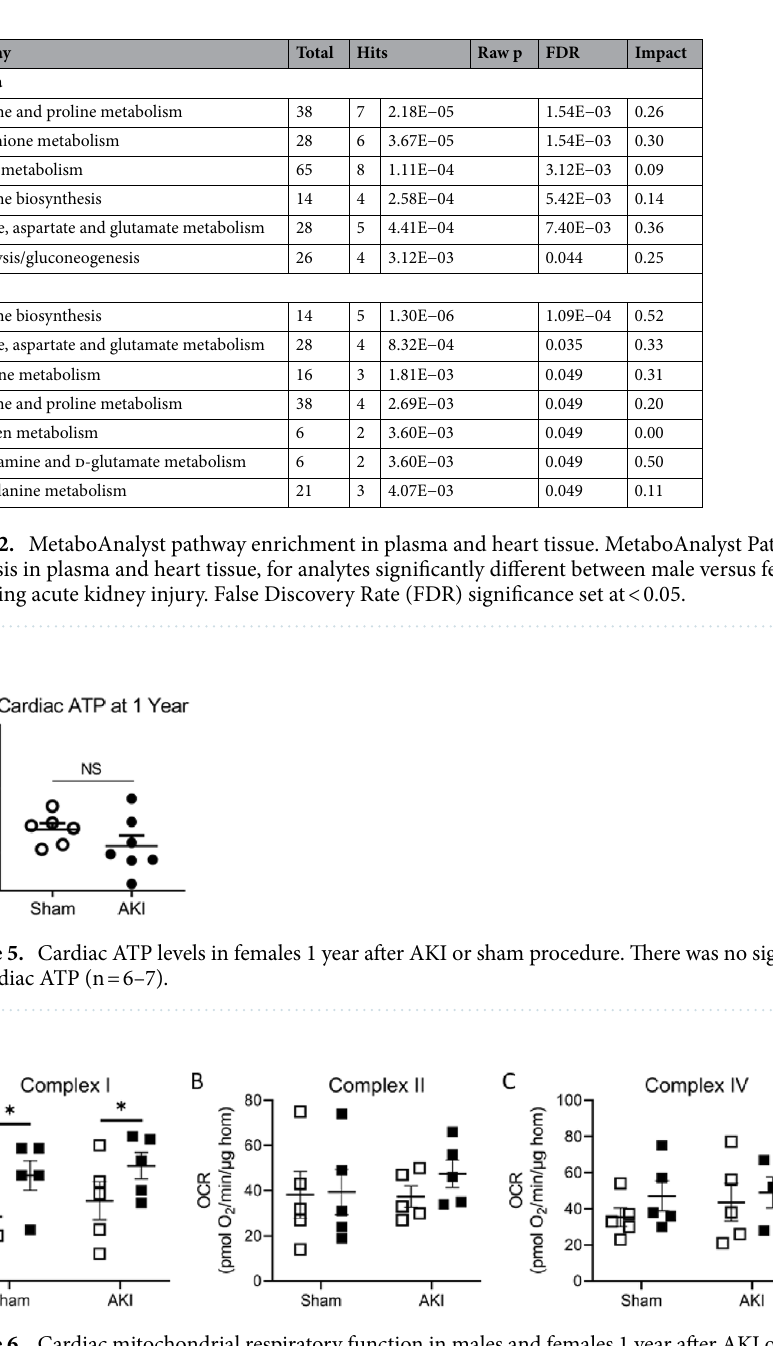
Figure 6. Cardiac mitochondrial respiratory function in males and females 1 year after AKI or sham procedure. ( A ) Females demonstrated higher oxygen consumption rate (OCR) in Complex I compared to males, regardless of AKI or sham status. There was no difference in Complex II ( B ) or Complex IV ( C ) with respect to either sex or AKI. (n = 5–7) *Signifies P <